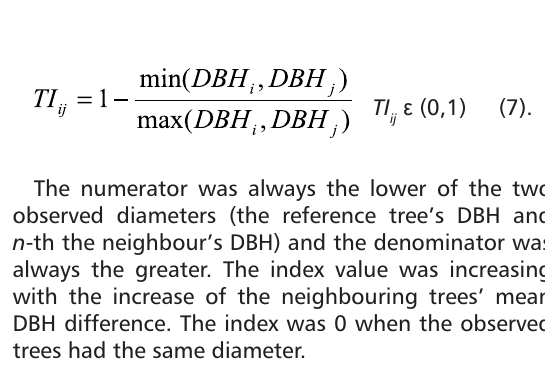
The diameter differentiation index (TI the spatial distribution of tree diameters. For the reference tree ‘ i ’ and its n=3 or the 4 nearest neighbouring trees, ‘ j ’ the diameter differentiation ) was defined as shown below (Equation 7): index (TI ij